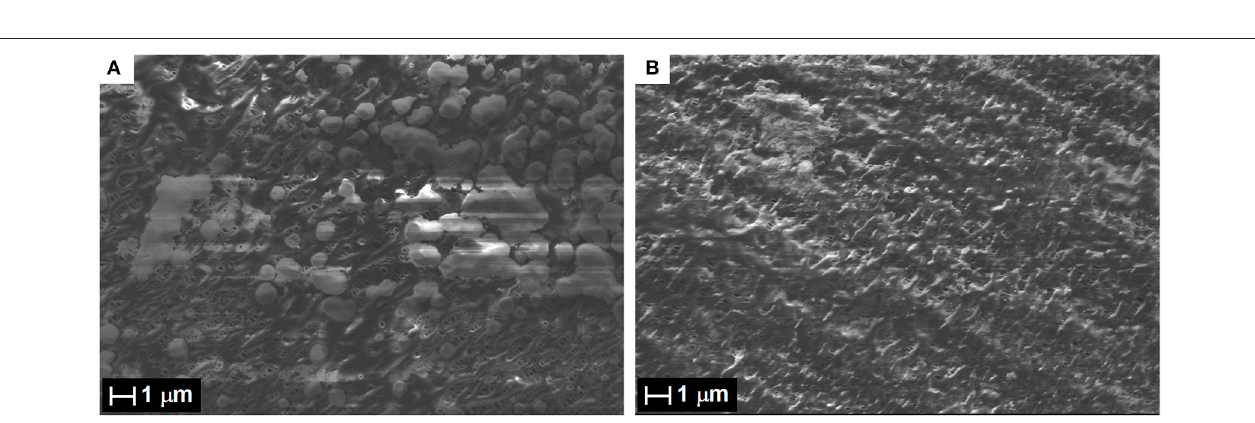
FIGURE 12 | SEM image of the cycled Celgard separators (facing the cathode) of the cylindrical neutron powder diffraction Li-ion cell after 65 cycles: (A) unwashed foil and (B) foil washed with